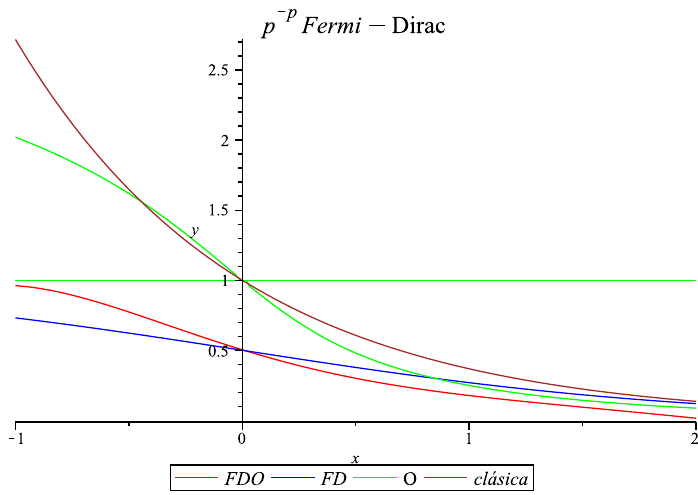
Figure 8. Comparison of FD with FDO ( n corresponds to FDO, blue line to FD usual, green line to g